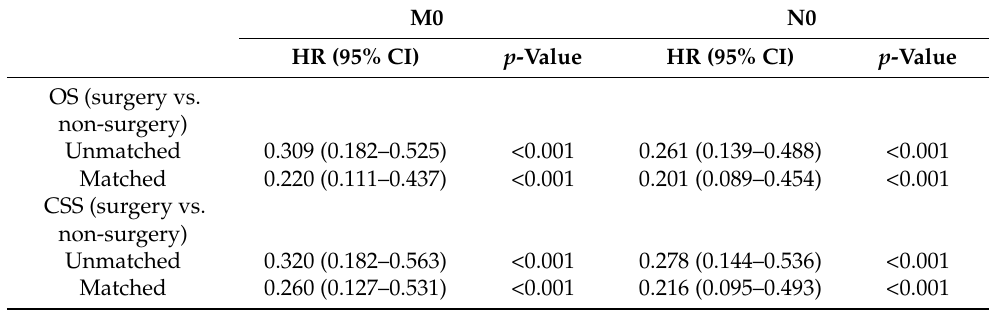
Table 5. Comparison of survival benefit of OS and CSS for ICC patients above 80 years